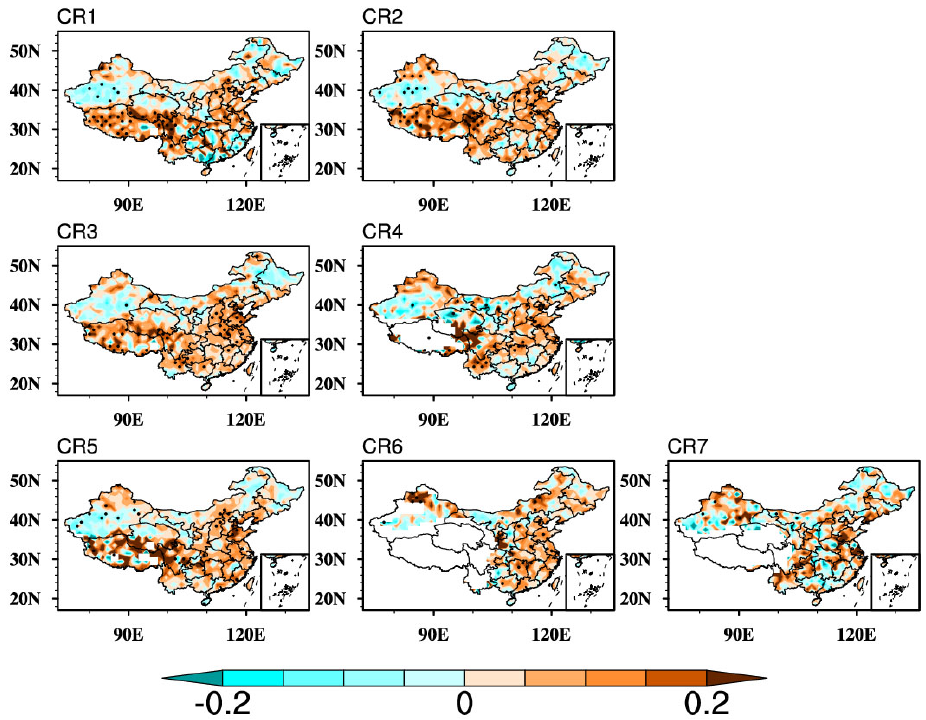
Figure 7. Same as Figure 5 but for correlation coefficient between LWP and AOD.